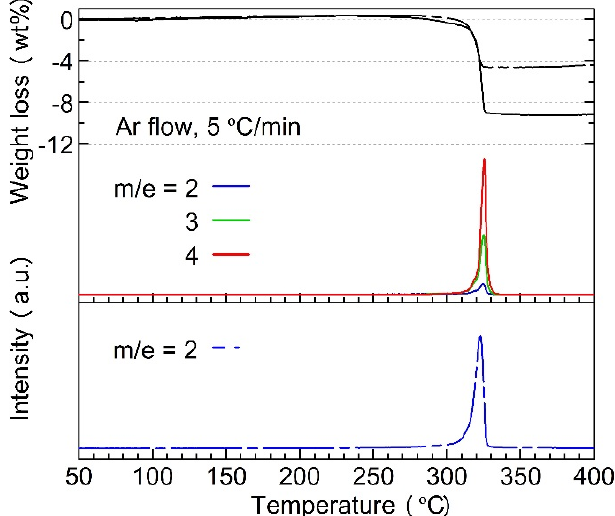
Figure 1. TG–MS profile of 0.25LiBH 4 + 0.75Mg 2 FeD 6 (solid line) and 0.25LiBH 4 + 0.75Mg 2 FeH 6 (dash line). m / e = 2, 3, and 4 are signals of H 2 , HD, and D 2 ,